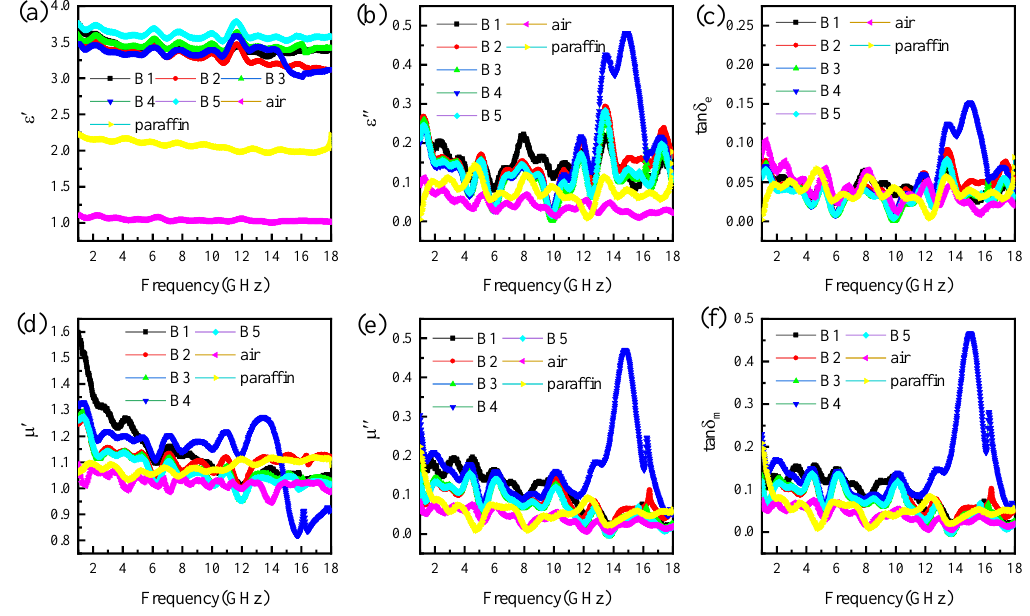
Figure 6. Frequency dependence of complex relative permittivity ( a – c ) and permeability ( d – f ) for the paraffin composites at a fixed absorbent content of 50 wt %.